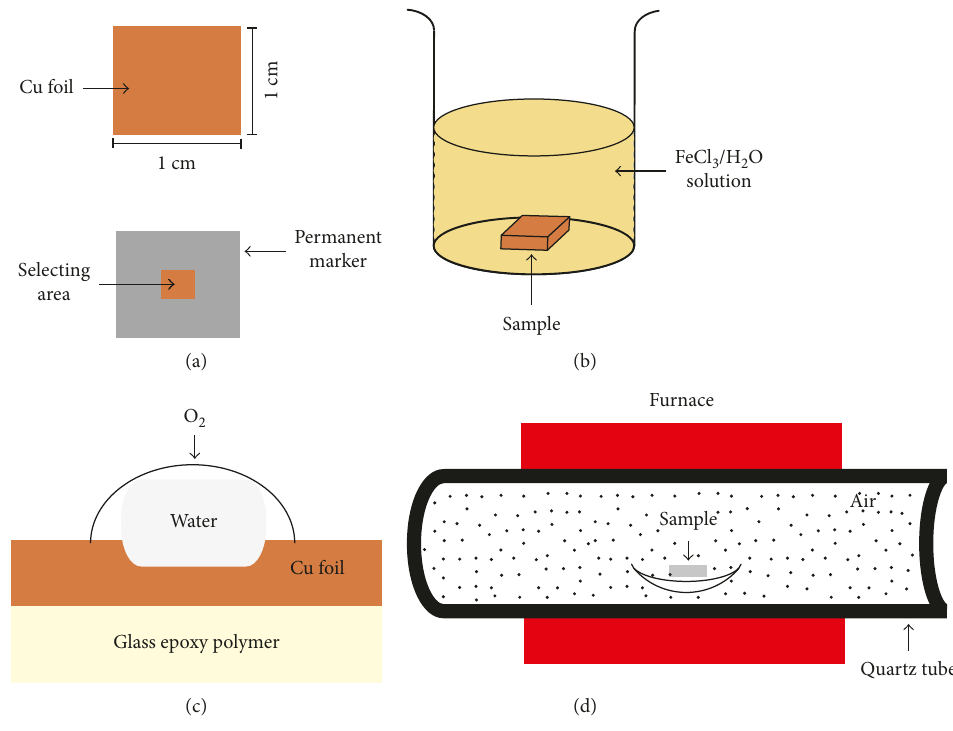
Figure 2: Stages employed in the synthesis of Cu oxide films.